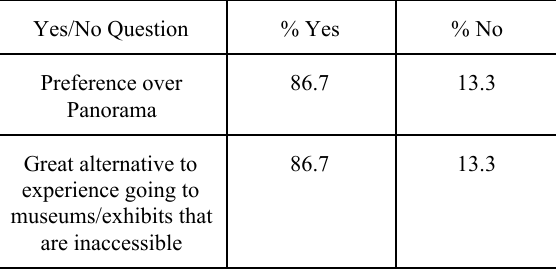
Table 7. Summary to yes or no